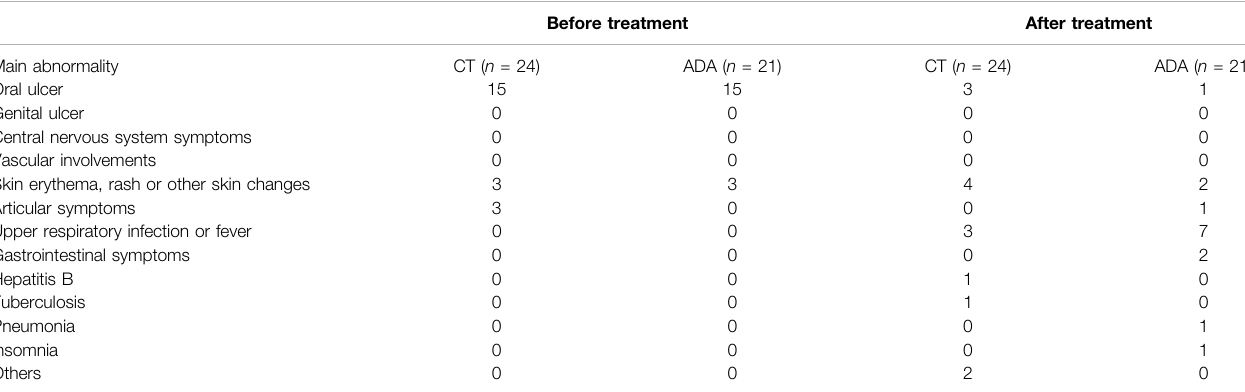
Before treatment After treatment